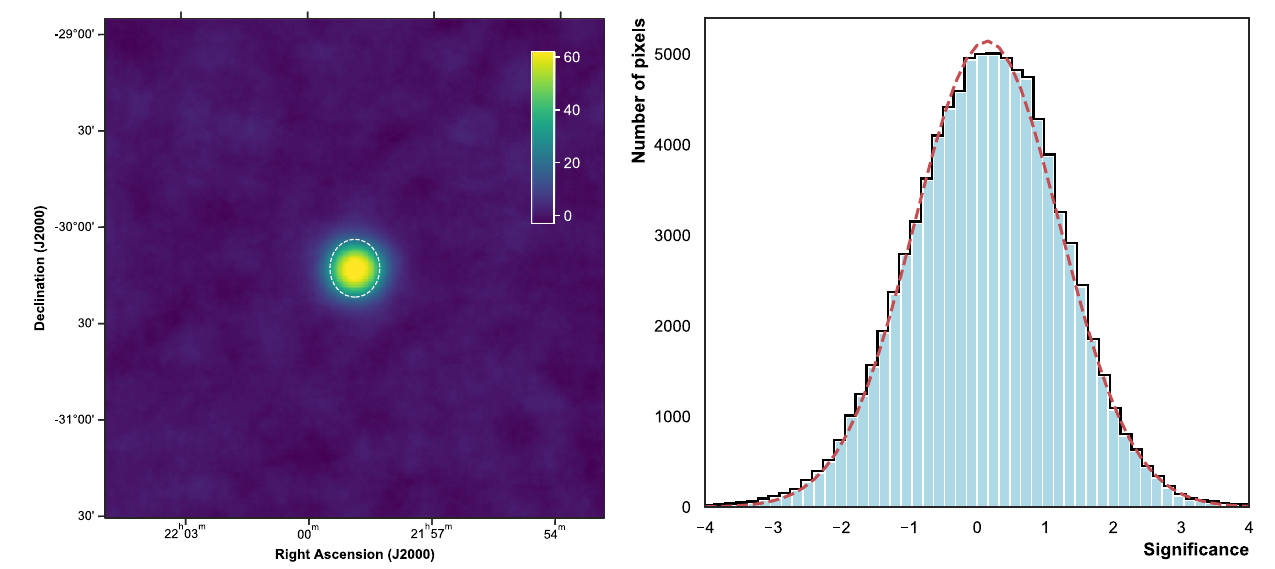
distribution of significance from signal-free pixels (solid histogram), shown in comparison with the best-fit Gaussian